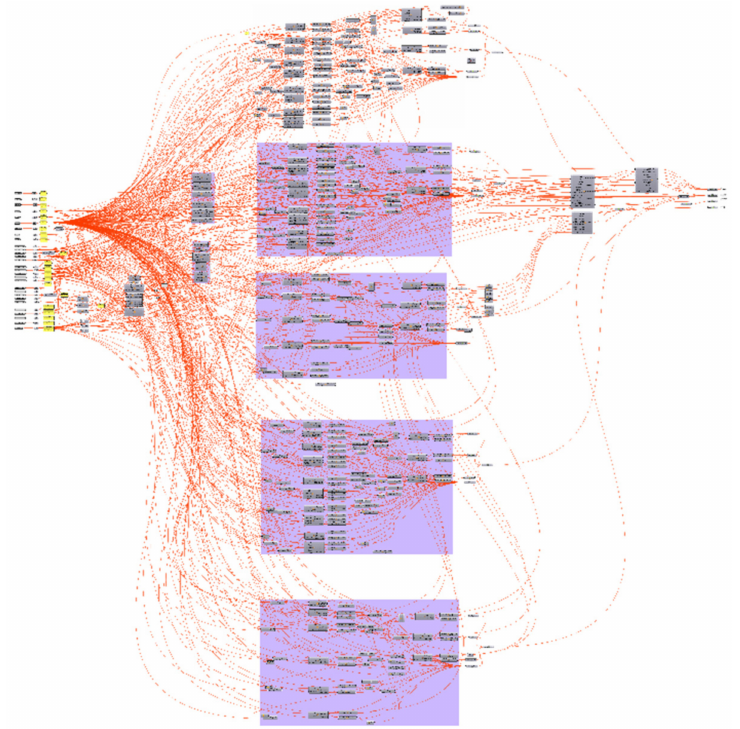
Figure 1. The Grasshopper modeling algorithms for regularized rebuild.